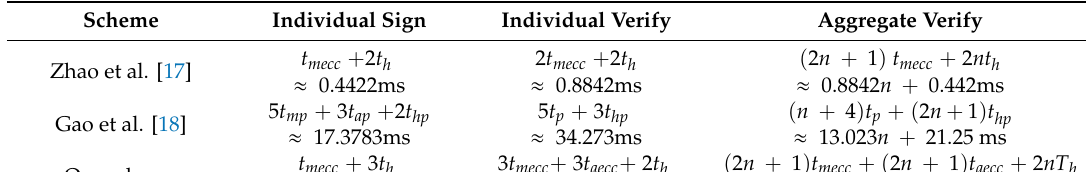
Table 7. Computation cost of schemes based on blockchain.